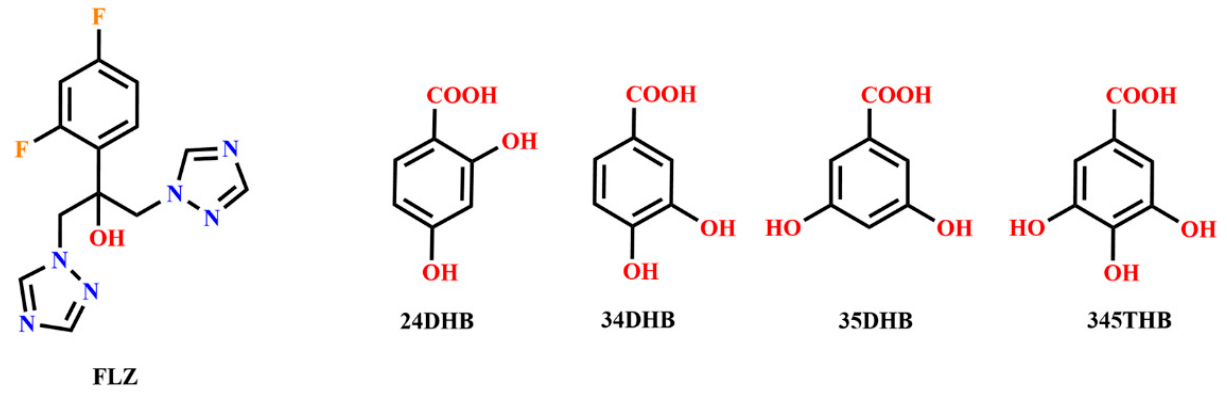
Figure 1. Molecular diagram of FLZ and the phenolic acids used in this study.